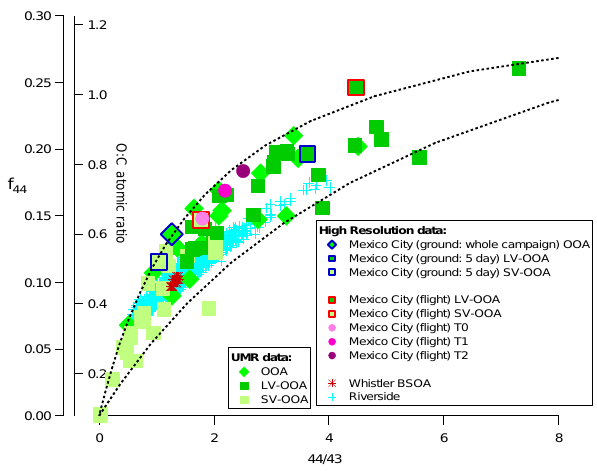
Fig. 5. f 44 and O:C vs. 44/43 for all the OOA components from different sites, including Mexico city ground (whole campaign and 5 day) (Aiken et al., 2008; Aiken et al., 2009b) and flight data (Jimenez et al., 2009). Also shown are the time-dependent data of the OOA components at Riverside, as well as data obtained dur- ing a biogenics SOA event at Whistler. For the UMR data, O:C is estimated using the f 44 of the PMF-resolved factor mass spectra and the correlation derived by Aiken et al. (2008); for the HR data the O:C is directly determined by elemental analysis (hence the f 44 axis does not apply to the HR data). The two dotted curves represent the mathematical transformation of the two lines in Fig.